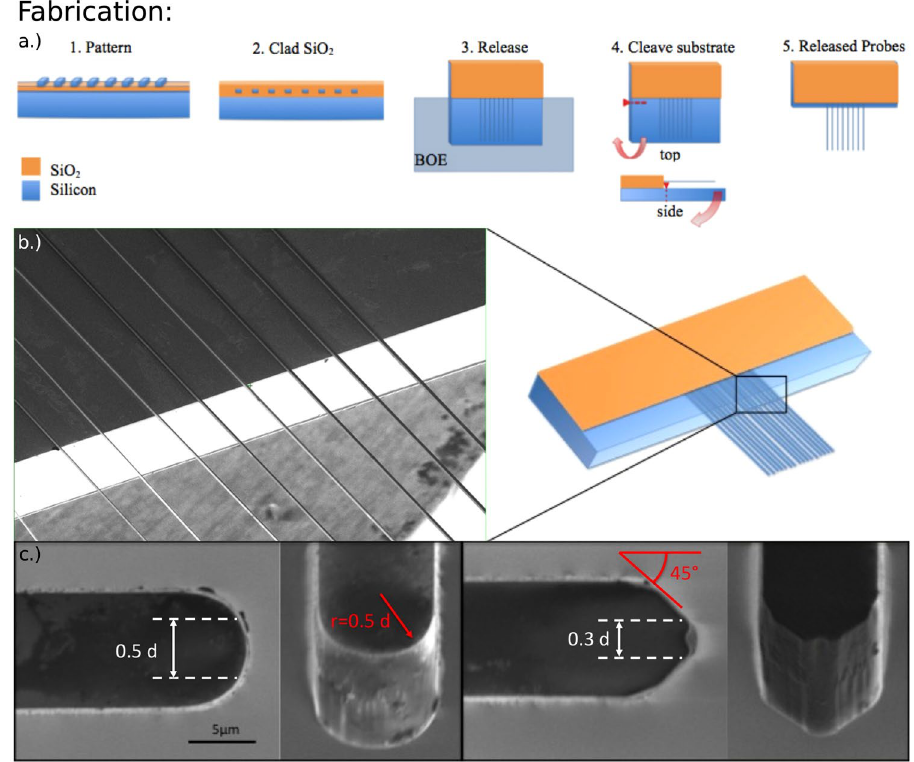
Figure 1. Details of the Photonic Needle fabrication using the Mechanical Substrate Removal (MSR) process. ( a ) Processing steps (left to right): ( 1 ) patterning of the Photonic Needle waveguides on the SOI wafer, ( 2 ) cladding the waveguides in PECVD oxide, ( 3 ) releasing diced chip vertically in BOE, ( 4 ) scribing at the base of the released section and mechanically cleaving off the substrate, ( 5 ) finally releasing the probes. ( b ) Scanning Electron Micrograph (SEM) of the Photonic Needles showing the pristine cleaved silicon face, post-MSR, at the interface between the portion of the chip where the needles are released and where they are not released (left). A schematic of the released needles indicating where the SEM was taken is shown on the right. Note that this pristine surface is in contrast to typical rough etched surfaces resulting from long backside etches. ( c ) SEMs of both curved (left) and angled (right) Photonic Needle tips, taken from the top of the chip and at a 45 degree angle relative to the chip. Note that the top faces are much smoother than the sides, showing that the sidewall roughness is primarily due to the initial waveguide etch process and not any part of the release process. The dimensions in white are referring to the approximate effective cross-sections, which mediate the critical force for insertion for each tip type, described in further detail with the data in Fig. 4. The dimensions in red indicate that the patterned radii of all the radiused tips are equal to half the width (d), and that the patterned angle of all the angled tips are at 45 degrees to the length of the